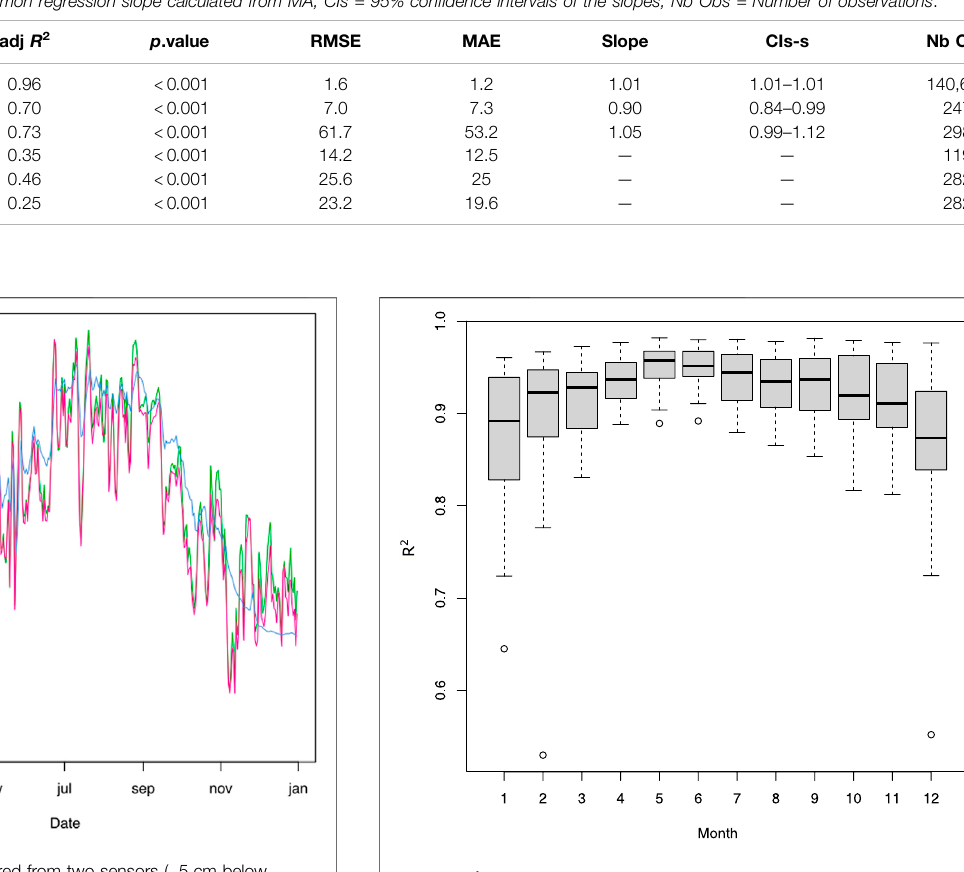
FIGURE3| Adjusted R squaredfromregressionsbetweendailyaverage temperatures calculated from the stations and from S2M. Regressions were computed for each station and